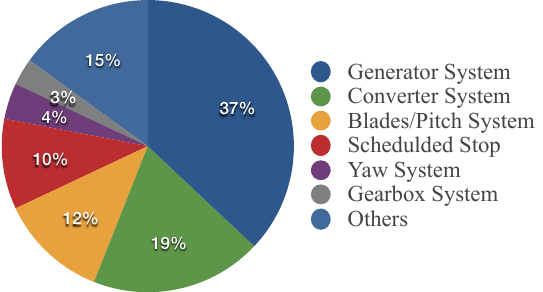
Figure 1. Percentage of downtime per component for two wind power plants in